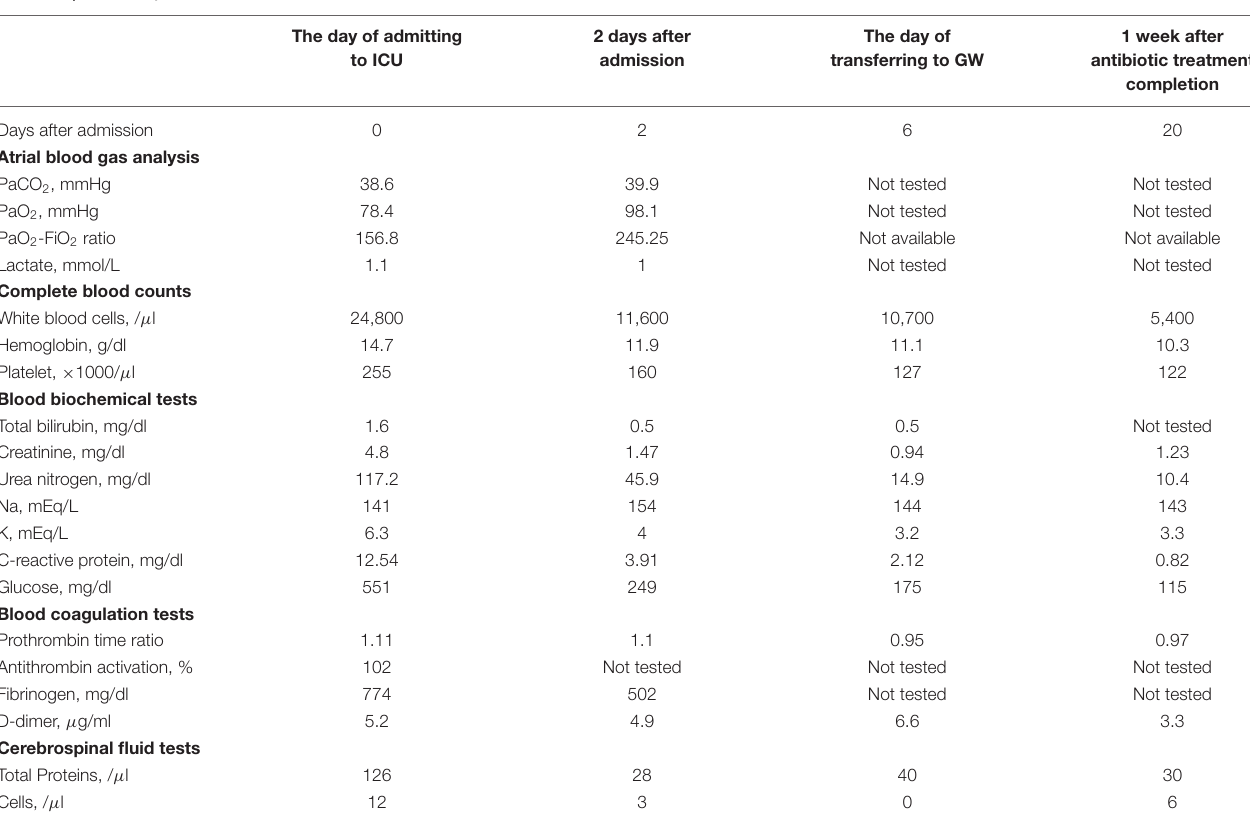
TABLE 2 | Laboratory